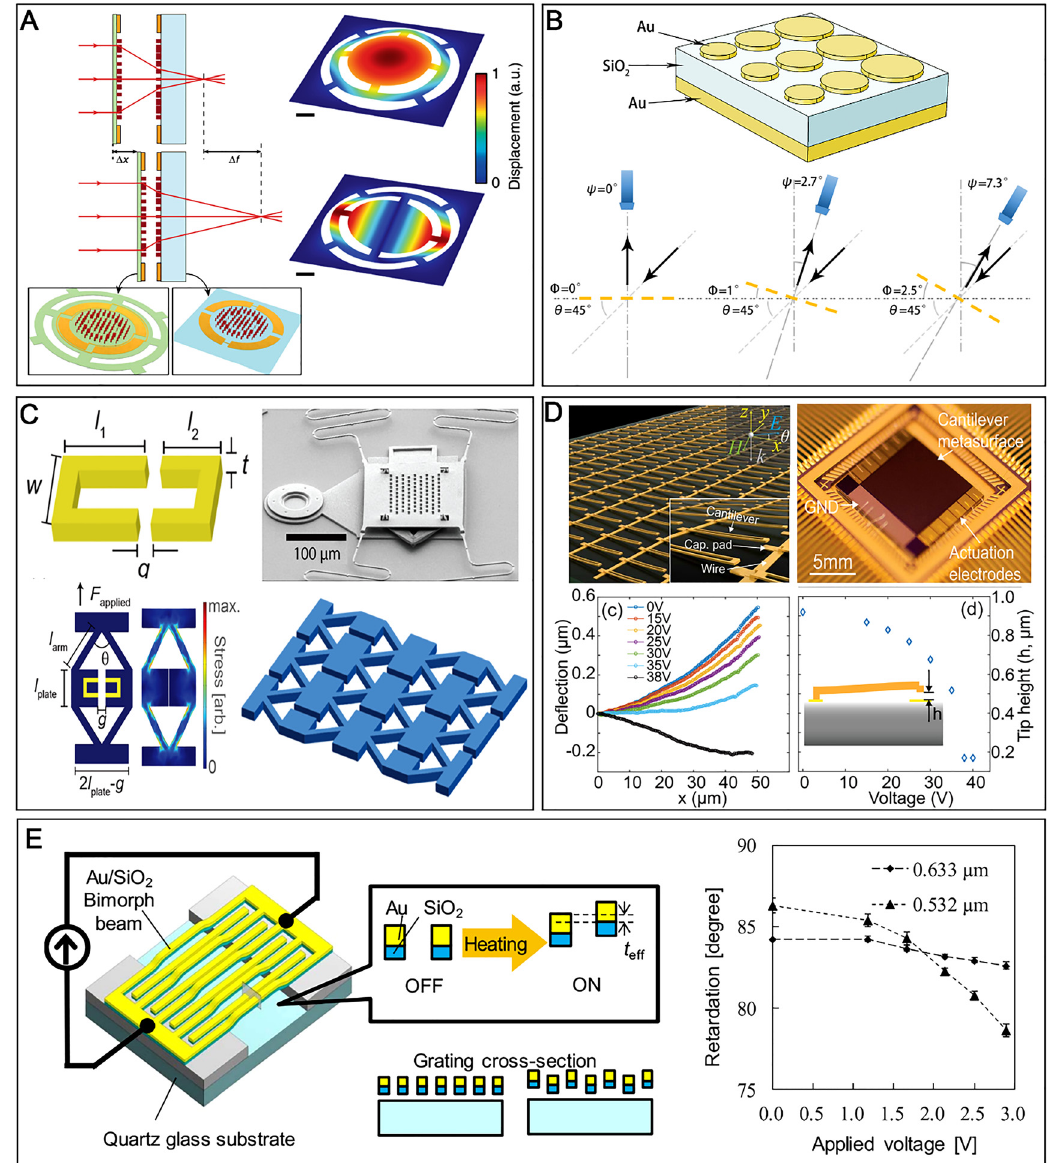
Figure 7: Tunable metasurfaces based on